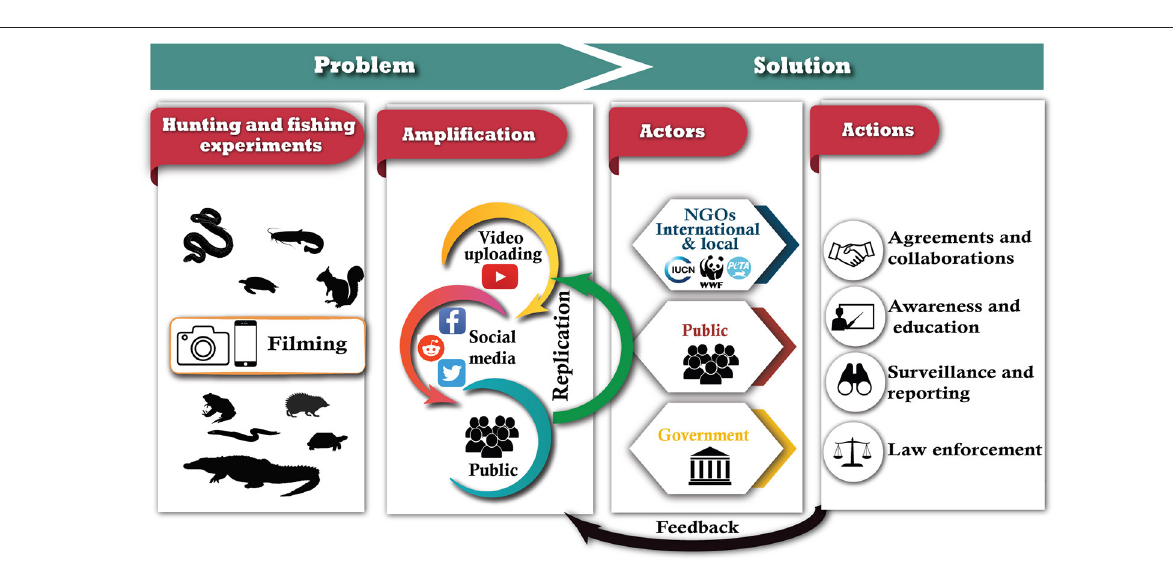
FIGURE 4 | Diagram presenting potential measures that should be taken by different actors to solve the problem of hunting and fishing experiments (HFE) on the internet. Combined efforts from international and national non-governmental organizations (NGOs), governments, business companies, and the public are needed to establish and apply measures that target the online platforms that spread HFE and demotivate the public from engaging in this kind of environmentally-damaging